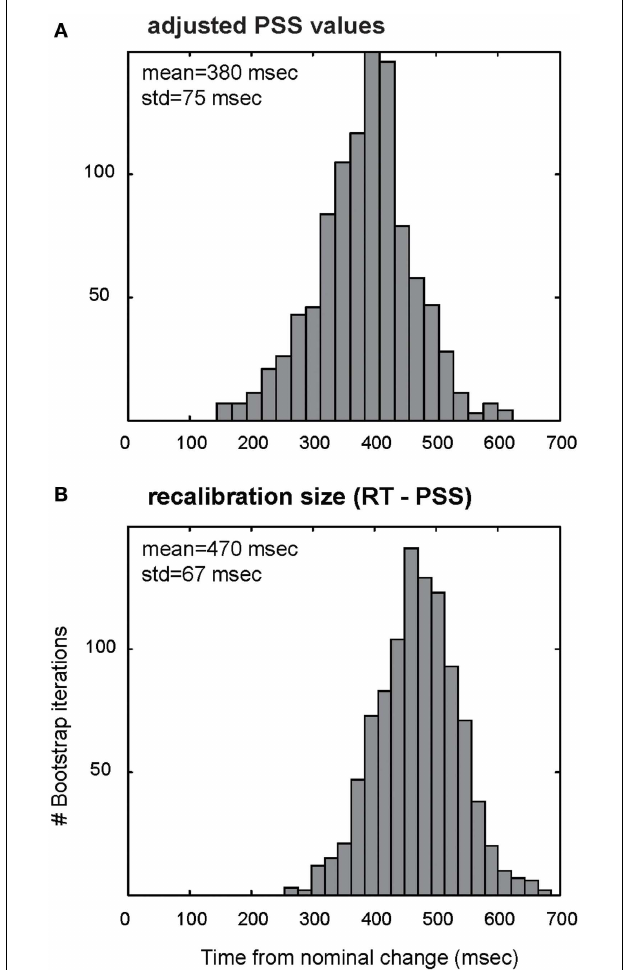
FIGURE 3 | Distributions of RAND-REG adjusted PSS values (A) and recalibration size (B) in Experiment 1 as computed with bootstrap resampling. (A) Gray bars: histogram of average PSS values obtained with a “repeated measures” bootstrap procedure, by which we repeatedly select with replacement a set of 15 subjects, estimate each individual PSS (including correction of RAND-REG PSS by the PSS of REG-RAND), compute the average over the group, and increment the appropriate histogram bin. (B) Same for recalibration size